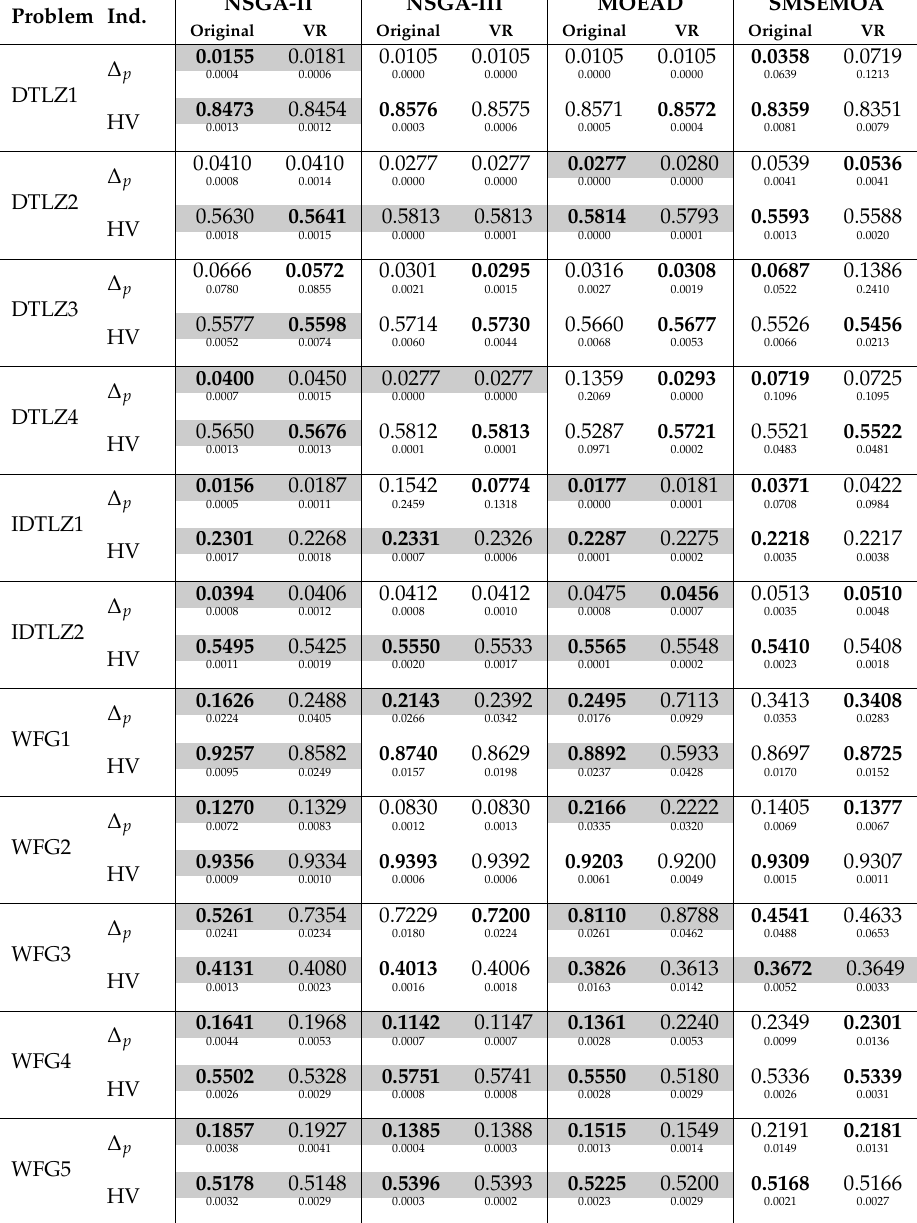
Table 2. Numerical results for the original and variation rate version of some MOEAs in standard benchmark test problems. We show the mean and standard deviation (up and down in the cell, respectively). We put in bold the best value and in gray the cells with statistical significance according to the Wilcoxon